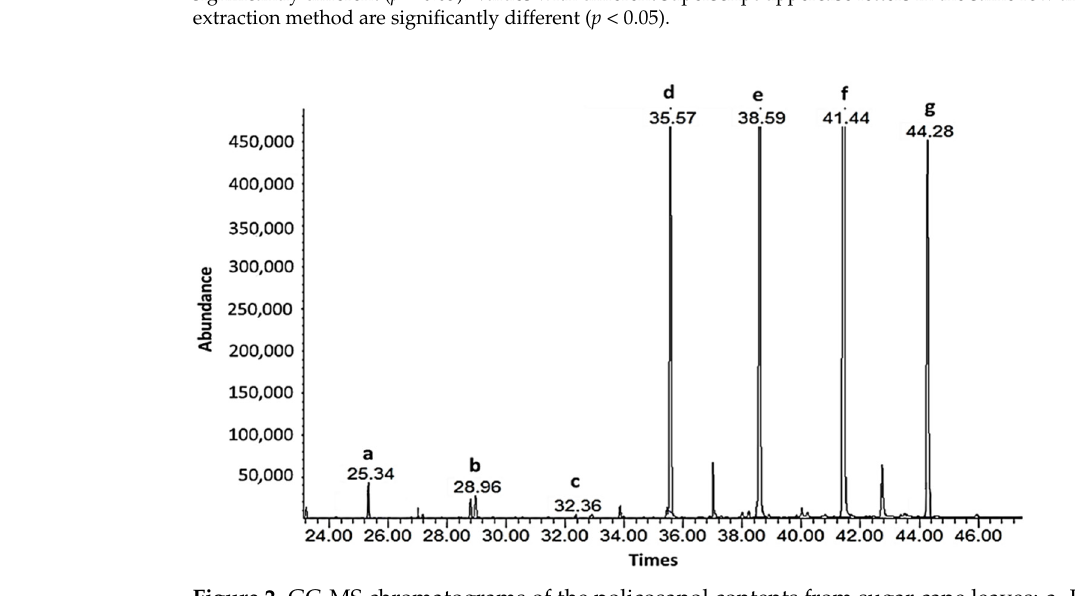
Figure 2. GC-MS chromatograms of the policosanol contents from sugar cane leaves: a. Docosanol (C-22); b. Tetracosanol (C-24); c. Hexacosanol (C-26); d. Octacosanol (C-28); e. Triacosanol (C-30); f. Dotriacontanol (C-32); g. Tetratriacontanol (C-34).